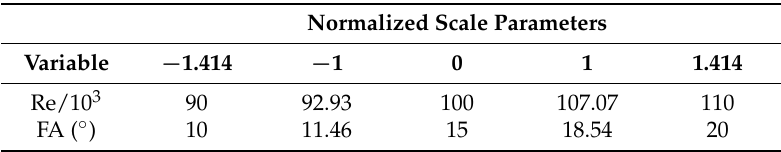
Table 1. Factor levels and the natural values of the variables (BA = 5°).